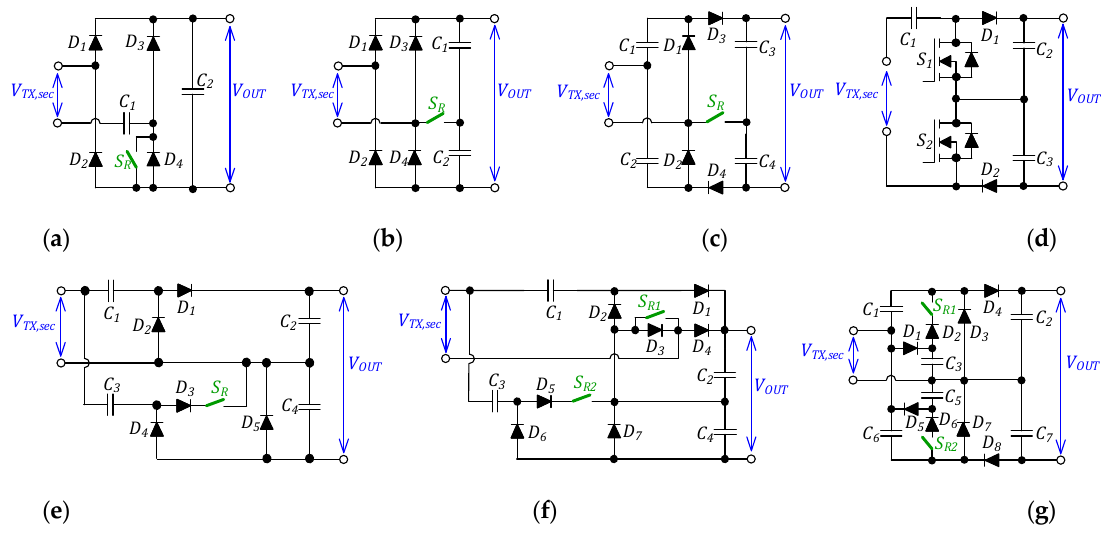
Figure 2. State-of-the-art multi-mode rectifiers: passive full-bridge/Greinacher voltage doubler rectifier [5] ( a ), passive full-bridge/symmetrical voltage doubler rectifier [20,21] ( b ), passive symmetrical voltage doubler/voltage quadrupler rectifier [14] ( c ), semiactive voltage doubler/voltage quadrupler rectifier [18] ( d ), passive voltage-doubler/voltage quadrupler rectifier based on two cascaded Greinacher voltage doubler cells [16] ( e ), passive full-bridge/voltage doubler/voltage quadrupler rectifier [13] ( f ), and 3-mode reconfigurable voltage multiplier rectifier [22] ( g ). Table 1. Main properties of the state-of-the-art MMRs.